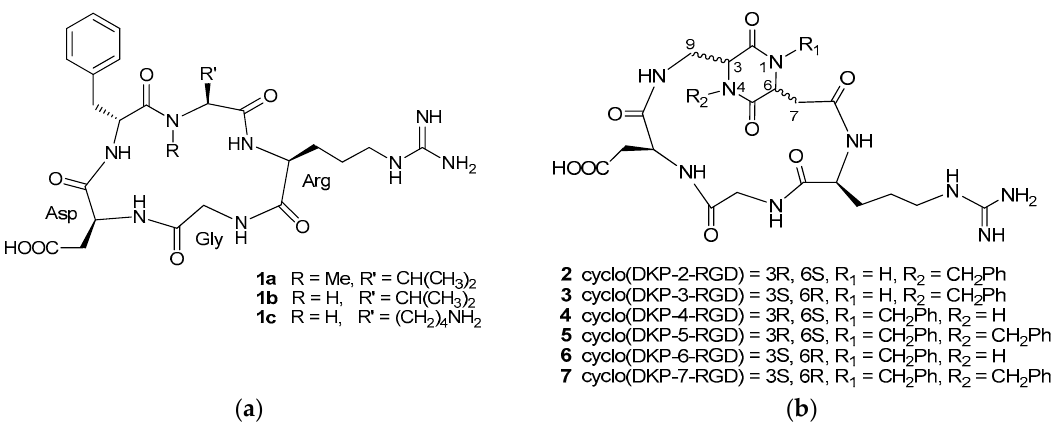
Figure 1. ( a ) Cyclic RGD (Arg-Gly-Asp) pentapeptides 1a – c ; ( b ) Cyclic RGD peptidomimetics 2 – 7 containing DKP scaffolds.